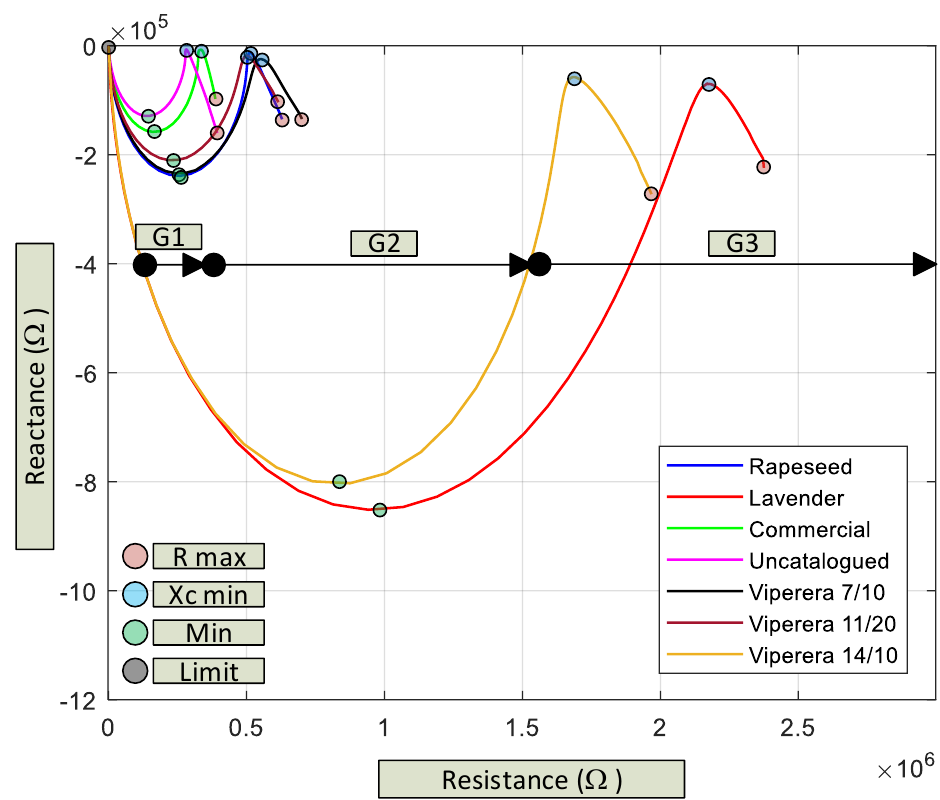
Figure 3. Evolution of the electrical impedance in the honey samples obtained. Each curve has a characteristic evolution, see Tables 3 – 5: Table 3. Characteristic values at minimum frequency (1 Hz).